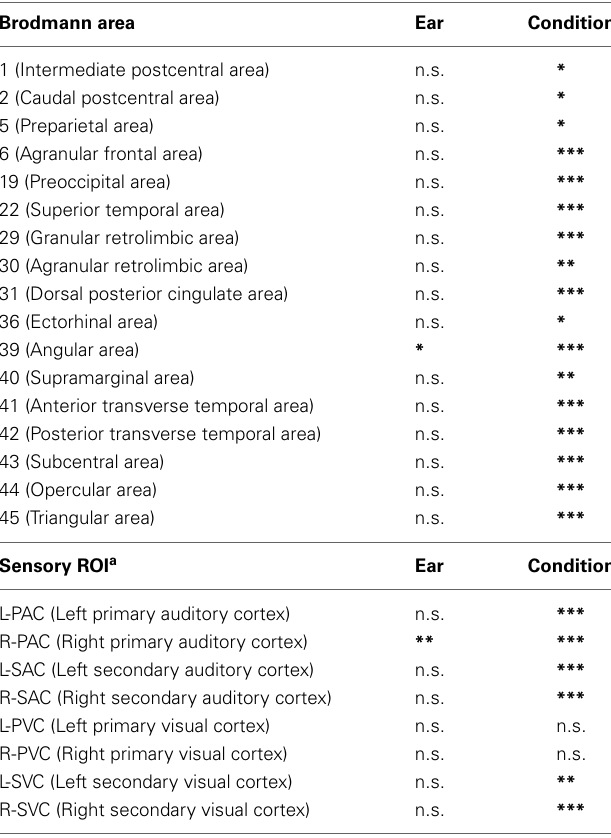
Table 1 | Significance of ROI activation for one or both of the factors defined in the ANOVA statistics, ear and